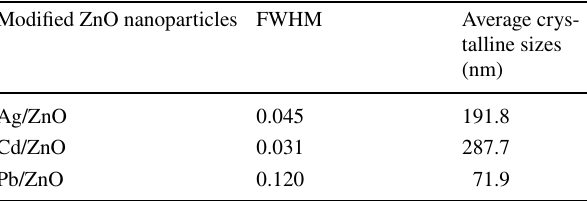
Table 1 Average crystalline size of modified ZnO nanoparticles Modified ZnO nanoparticles